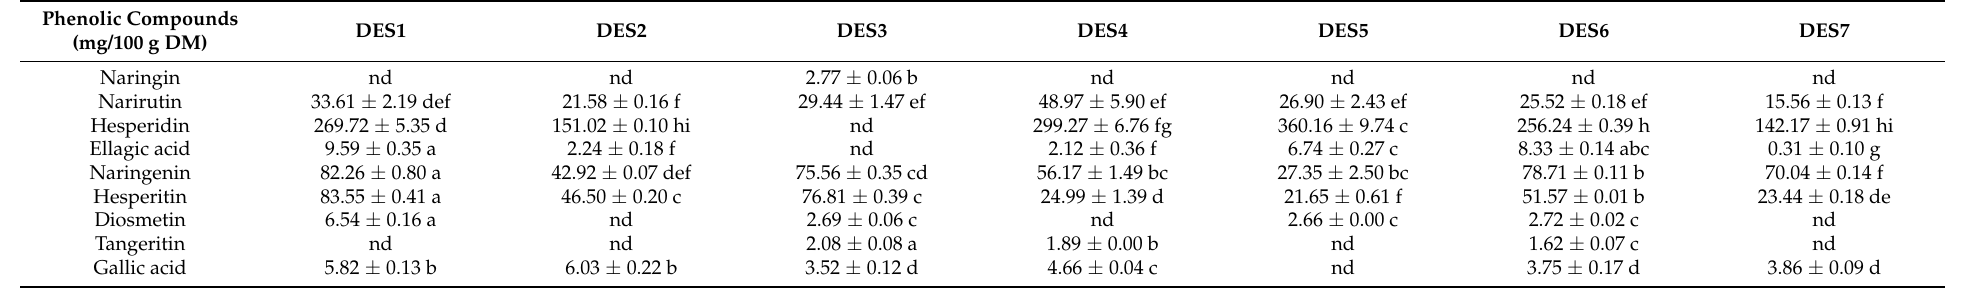
Table 8. Individual phenolic compounds obtained for group 2 extractions by Two-step